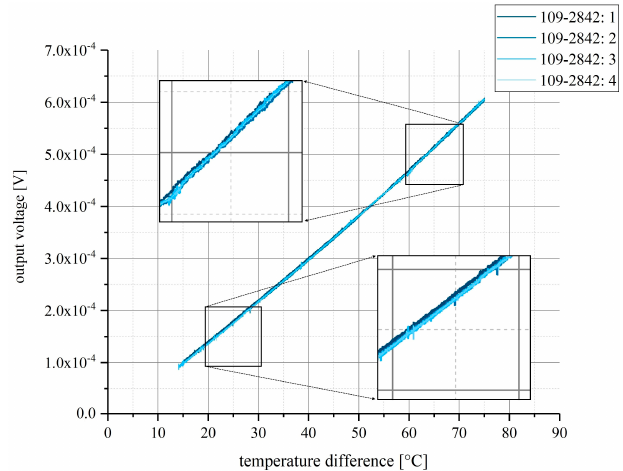
Figure 2. The output voltage of the pure carbon black thermocouple as a function of difference between junction temperature and connection temperature.